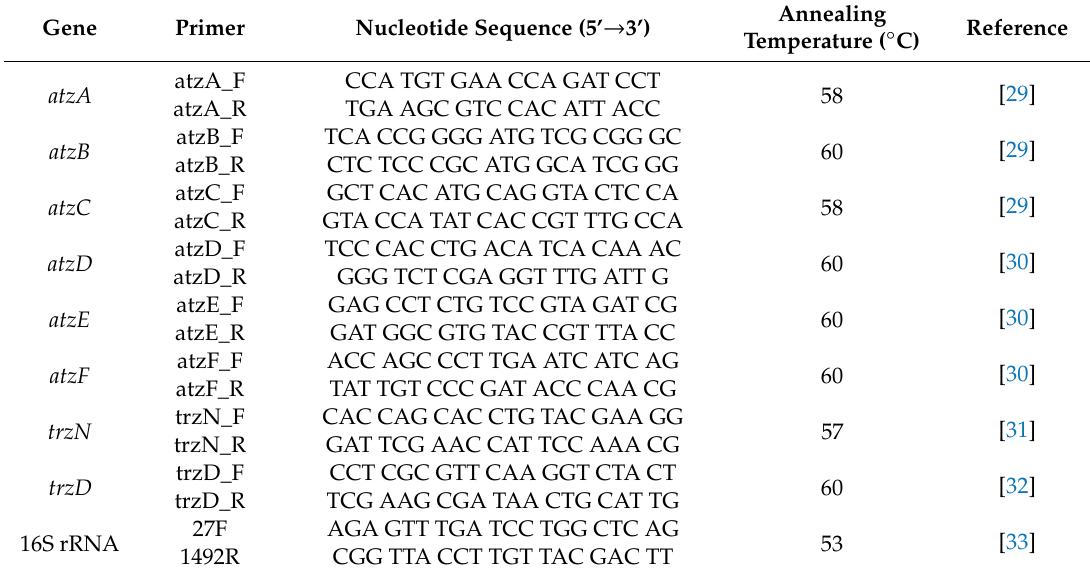
Table 1. Sequence and conditions of primer pairs used in this